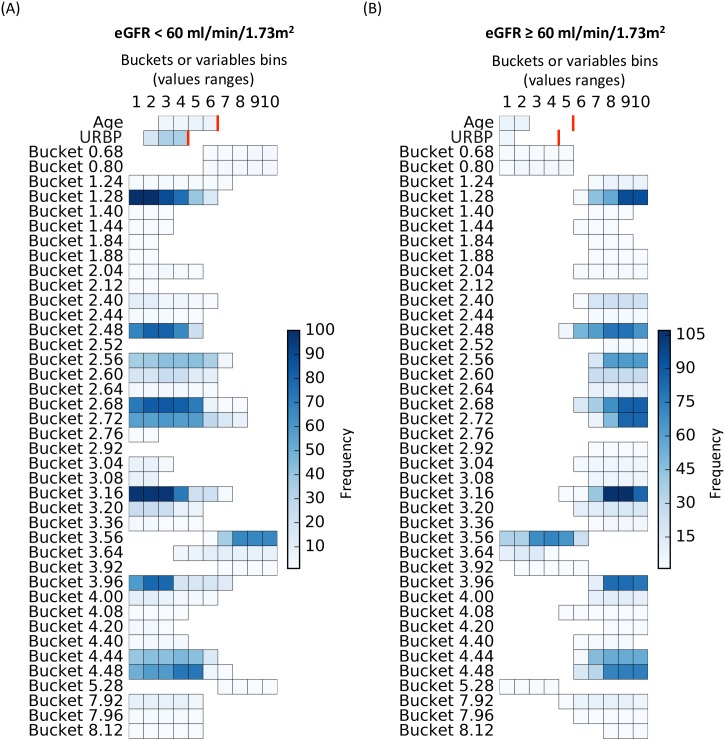
Variables’ frequency over the 100 multi-source local 1D models.Each horizontal segment corresponds to a 1D rule characterized by its variable condition: the variable’s name and the set of covered values or bins (n.b., ranges of bucket’s bins could be interpreted as relative concentrations). The color scale reflects the frequency of the variables’ values covered by the rules. As the two non-bucket variables were discretized according to the clinical relevance for the urinary retinol binding protein concentration (URBP) and the variable distribution for the Age, we indicated with a red line the corresponding upper bin of these two variables. The more robust the rule, the darker it will be. (A) shows the rules corresponding to the subgroup of patients with an eGFR < 60 ml/min/1.73m2 and conversely, (B) shows the rules corresponding to the subgroup of patients with an eGFR ≥ 60 ml/min/1.73m2.